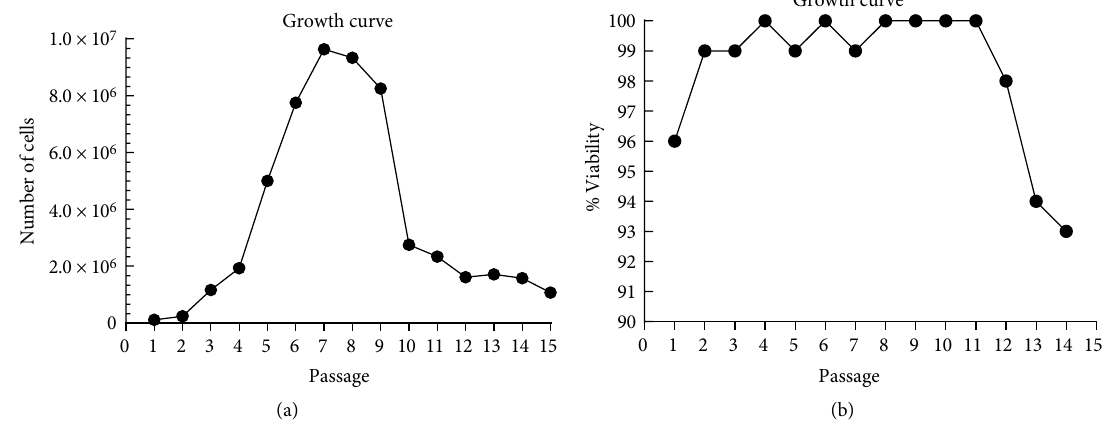
Figure 2: (a) OM-MSCs’ growth curve over 35 days (15 passages); (b) Variation of % cell viability over 35 days (15